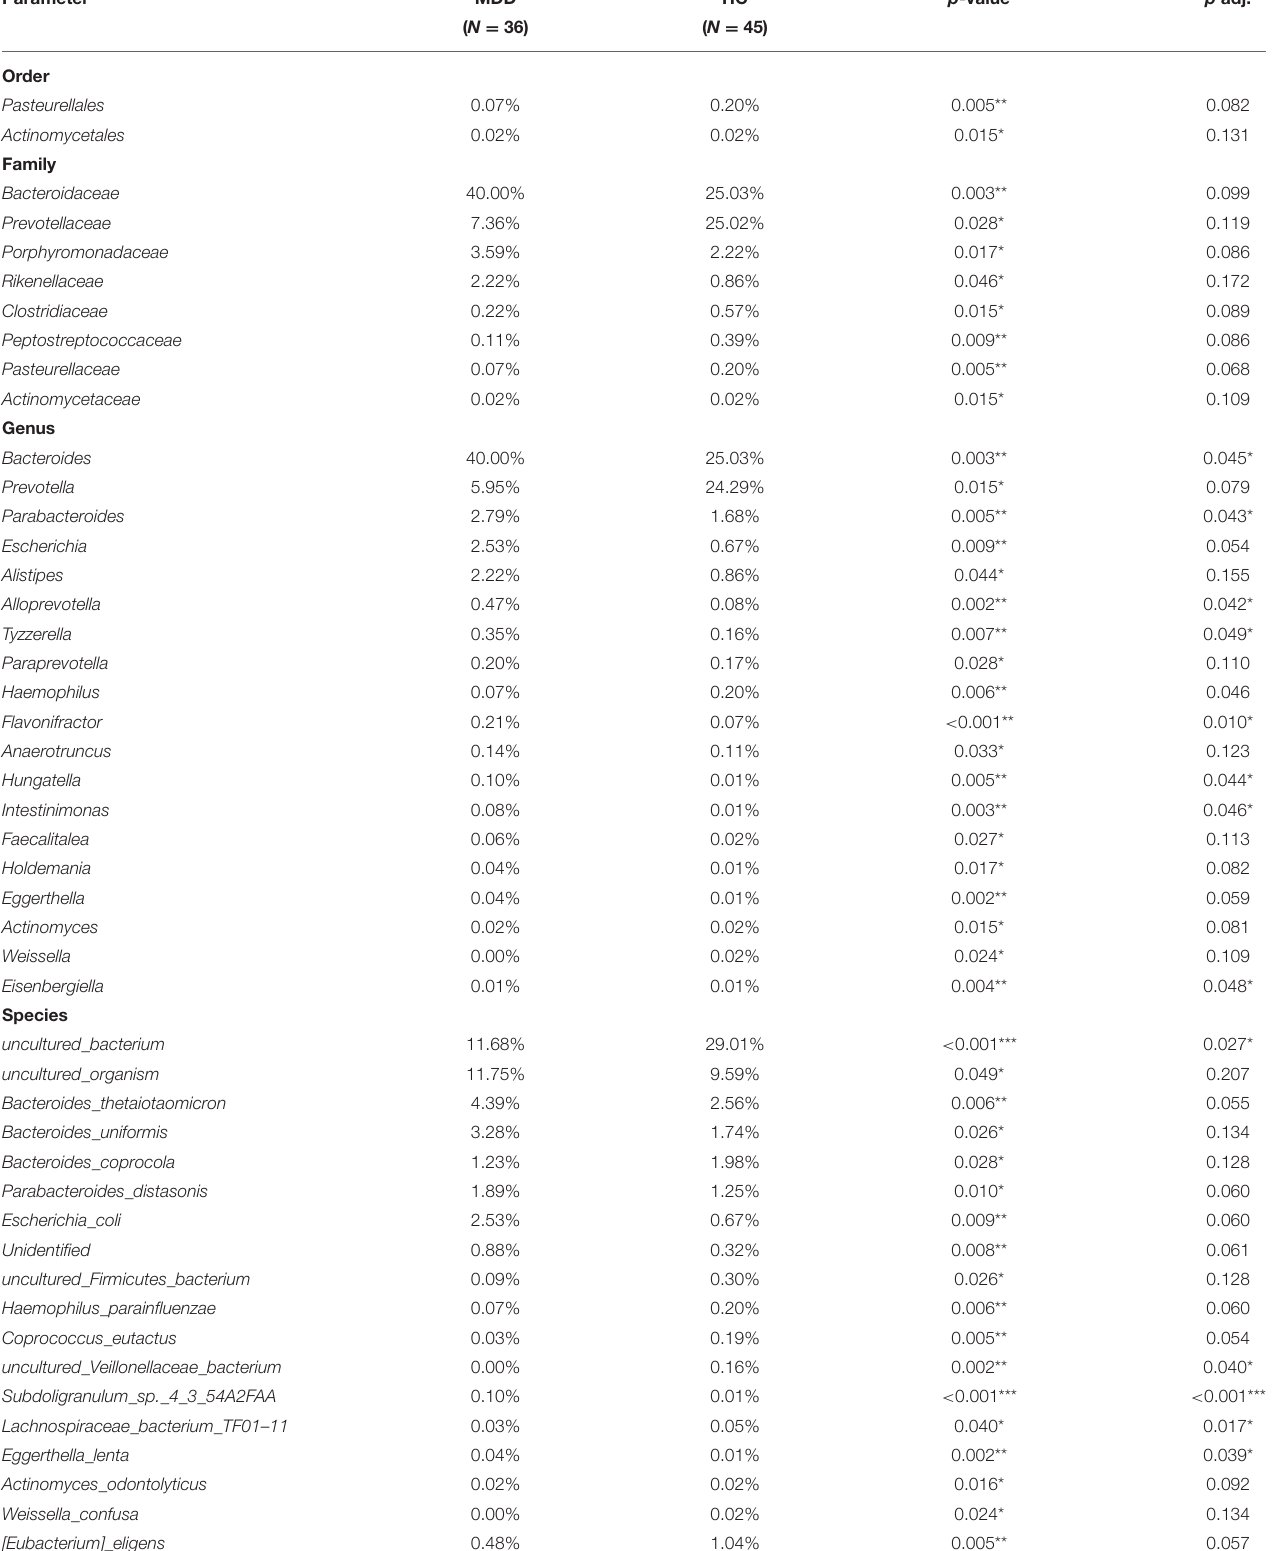
TABLE 2 | Taxa abundances in MDD and